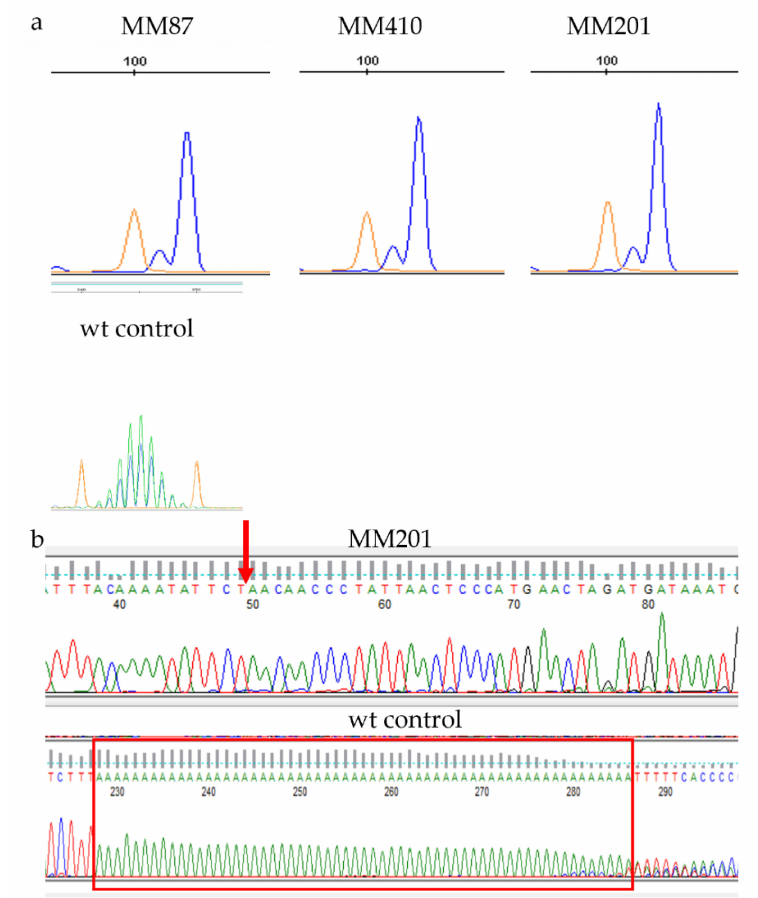
was used as control in green, and size standard is in orange.